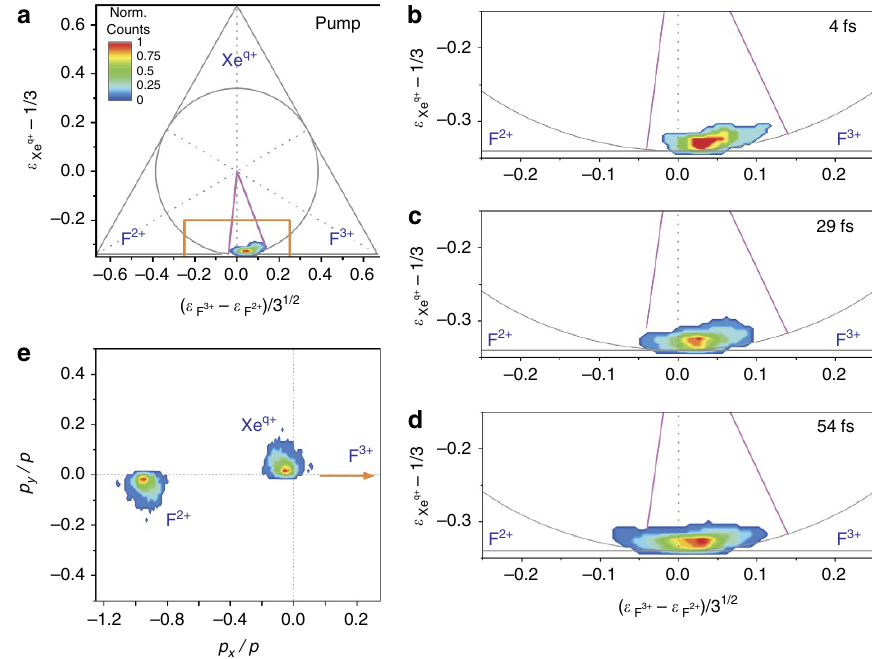
Figure 4 | Time-dependent ion momentum distribution. Dalitz plots of the F 2 þ –Xe q þ –F 3 þ break-up channel using 690-eV pump and 683-eV probe pulses. ( a ) The full Dalitz plot is shown for the pump-only data. ( b , c , d ) Pump-probe data for 4-, 29- and 54-fs time delays, respectively, are shown on an expanded scale. Only events with KER below the vertical line near 90eV in Fig. 3a are plotted. The magenta lines are markers of the pump-only data. The colour label has been normalized to the maximum of counts. Movement of the distributions towards the F 2 þ ion with increasing time delay is consistent with the identified pathways (1) and (2). ( e ) Newton diagram for the break-up channel F 2 þ –Xe q þ –F 3 þ : the linear momenta distribution is shown for the Xe q þ and F 2 þ ions, always rotating the reference framework in order to fix the direction of the linear momentum of F 3 þ in the (positive) p x -direction. The distribution indicates linear break-up of the molecular